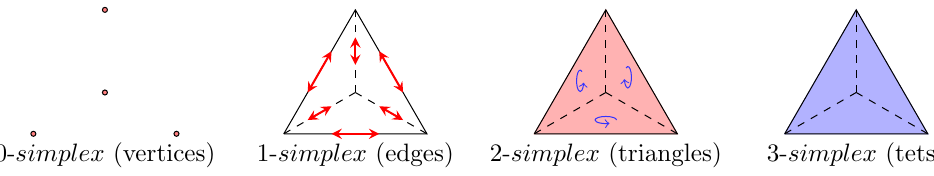
Figure 2. Examples of p -simplex for p = 0,1,2,3 in tetrahedron. A 0-simplex is a point, a 1-simplex is an edge with a convex hull of two points, a 2-simplex is a triangle with a convex hull of three distinct points, and a 3-simplex is a tetrahedron with a convex hull of four points [30]. Chain, Boundary, and